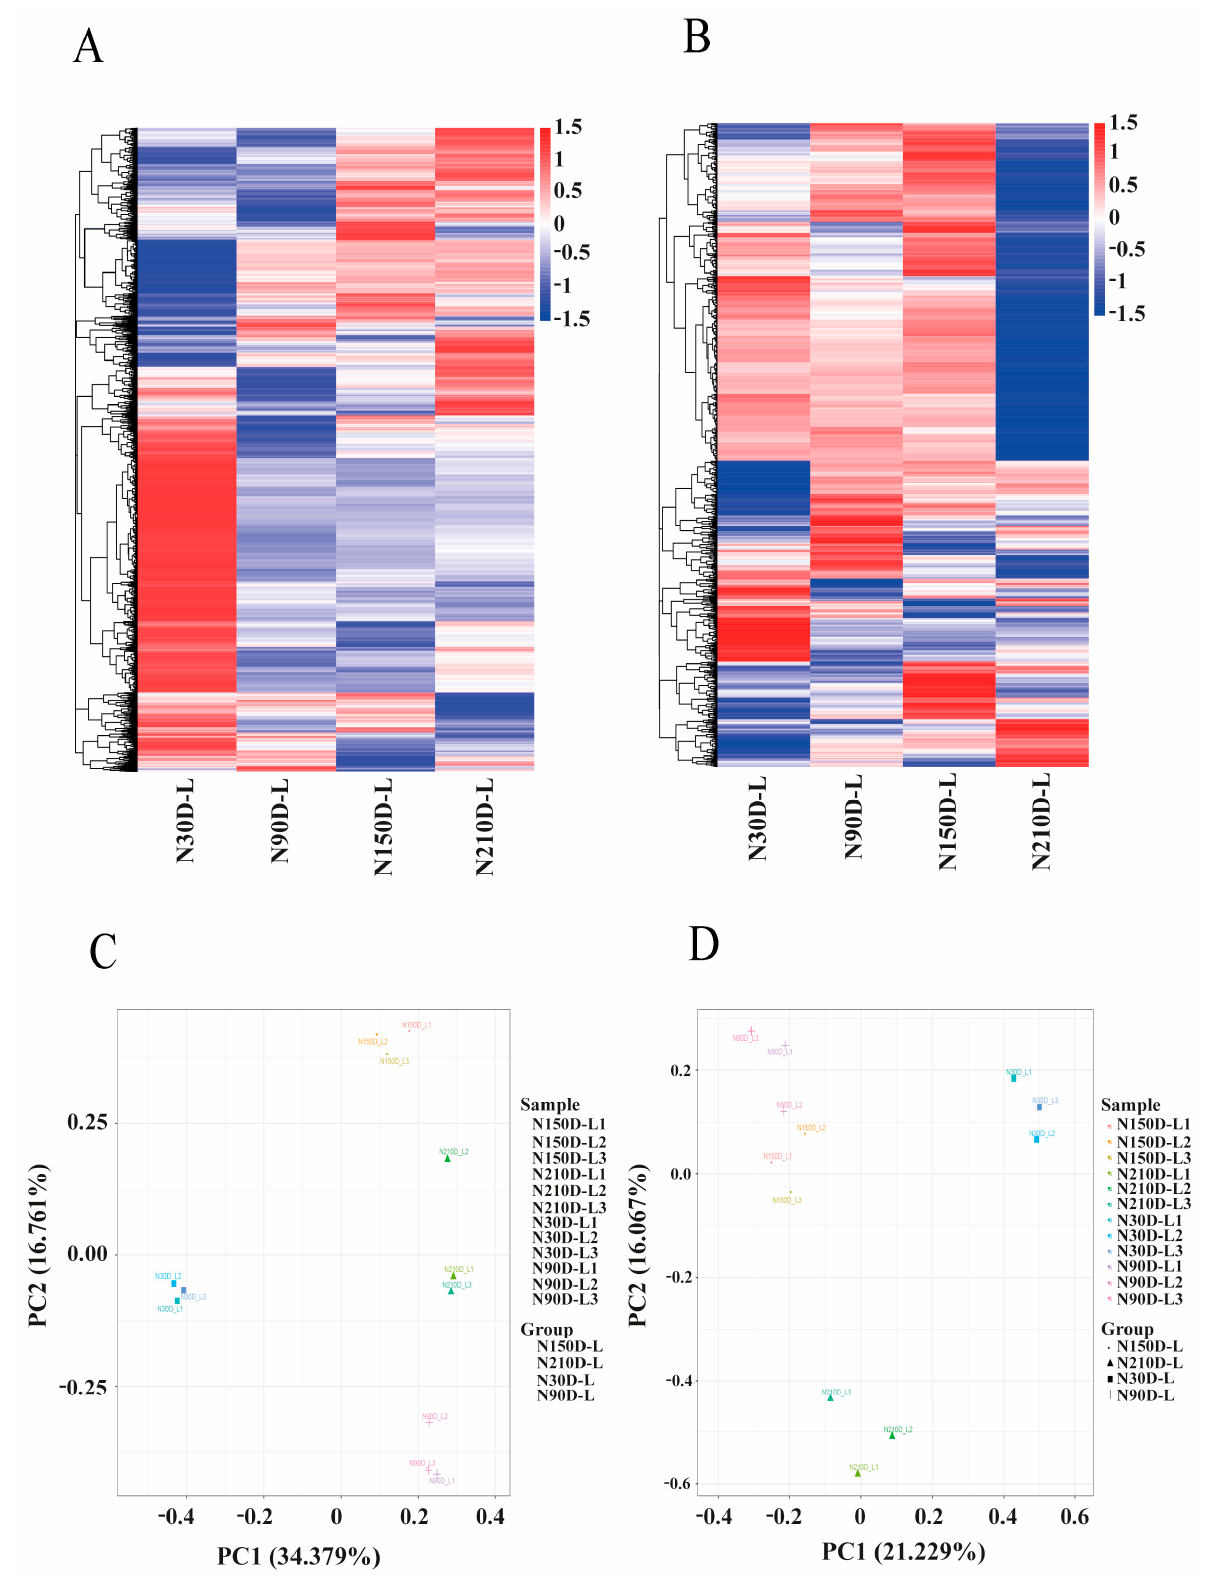
Figure 2. Heat maps of differentially expressed ( A ) mRNAs and ( B ) lncRNAs and their expression modes. Principal component analysis (PCA) of ( C ) lncRNAs and ( D ) mRNAs in 12 samples of liver at four stages of development.